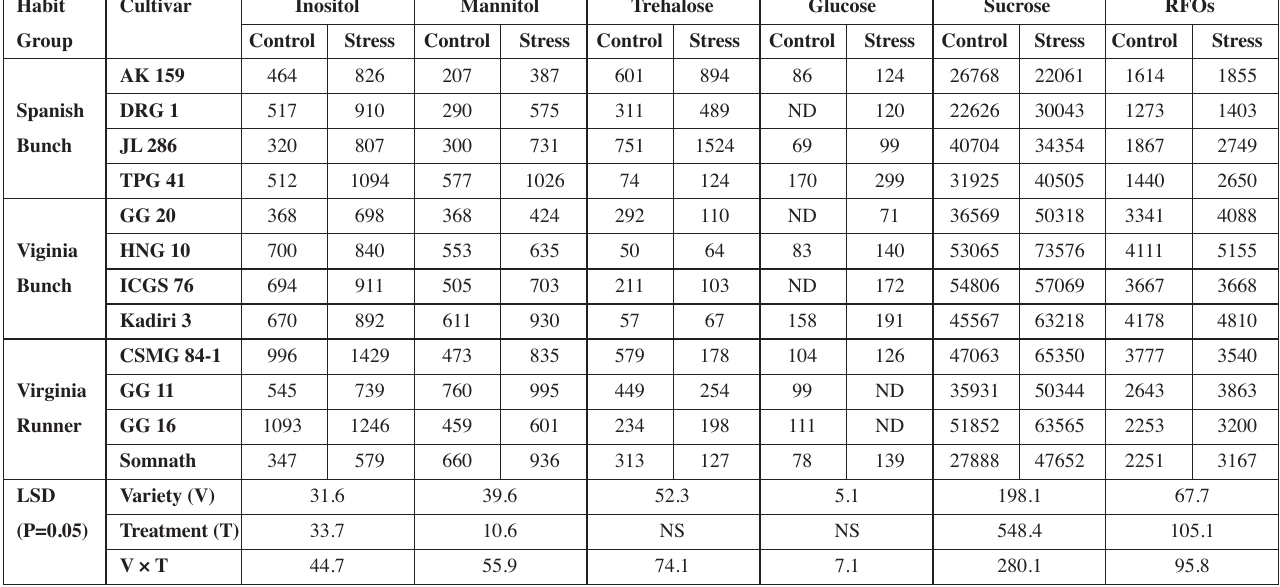
Tab. 3: Sugar profiles (ppm) of groundnut kernels during water deficit stress Habit